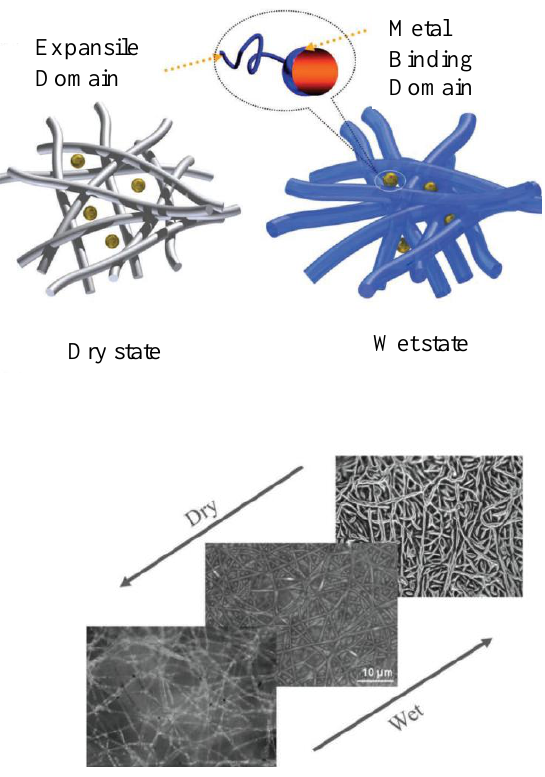
Figure 9. Capturing of metal nanoparticles through the wetting induced-conformational change of the proteins immobilized onto nanofibers